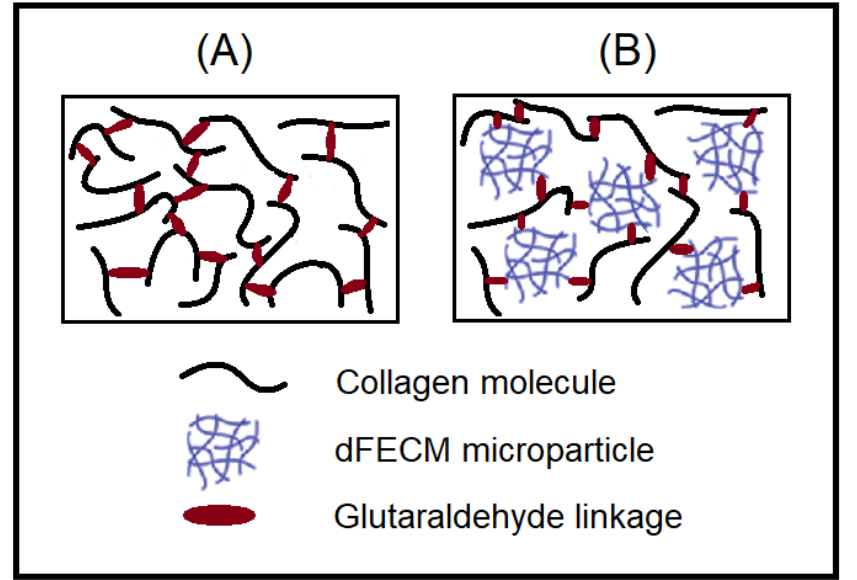
Figure 11. Schematic diagram for preparation of designed crosslinked composite bioscaffold. ( A ) cross-linked collagen and ( B ) cross-linked collagen and decellularized